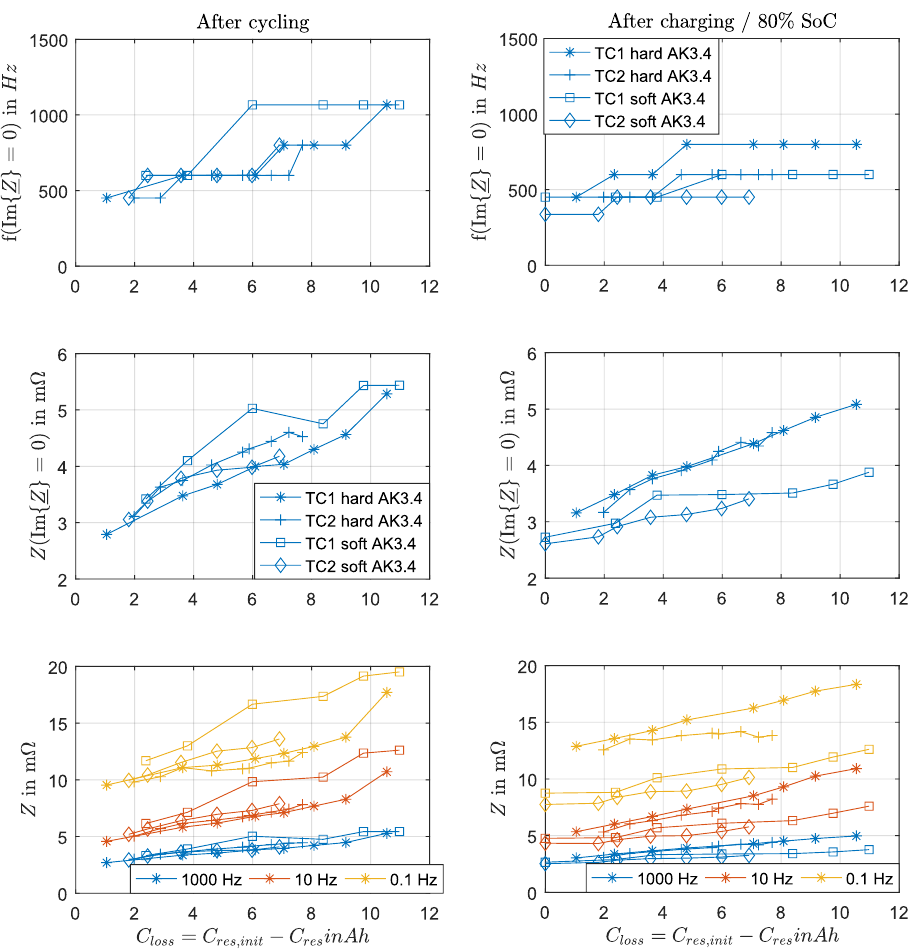
Figure 10. Single impedance values of all test cells in hard AK3.4 and soft AK3.4 test recorded with − 1I 20 after the cycling phase ( left ) and after charging ( right ). In the upper graph, the frequencies at which the imaginary part of impedance is near zero, are plotted over capacity loss C loss . In the middle graph, the corresponding impedance amplitudes are given. In the lower graph, impedance amplitudes measured at 0.1Hz, 10Hz, and 1kHz are presented. The data of different test cells are distinguishable by the marks and the different frequencies in the lower graph are distinguishable by the line